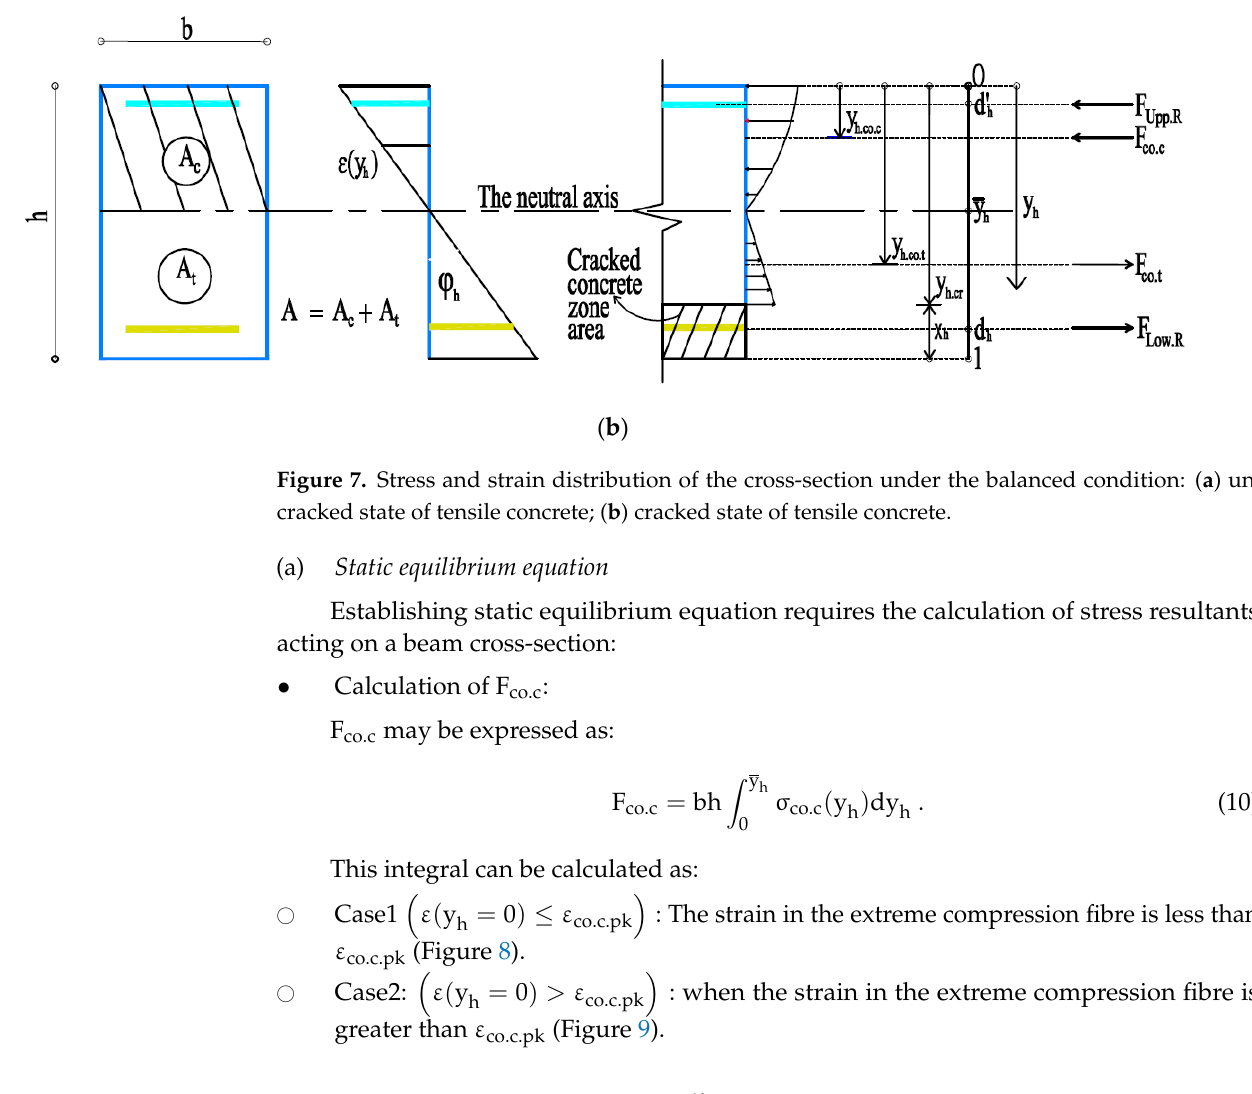
Figure 8. Stress–strain compressive concrete when (cid:3435)ε(y = 0) ≤ ε (cid:2913)(cid:2925).(cid:2913).(cid:2926)(cid:2921) (cid:3439).